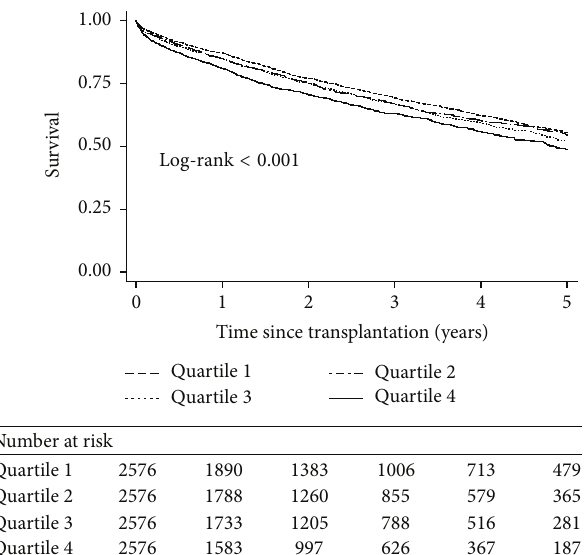
Figure 1: Kaplan-Meier survival curve after lung transplant, strati- fied by quartiles of lung allocation